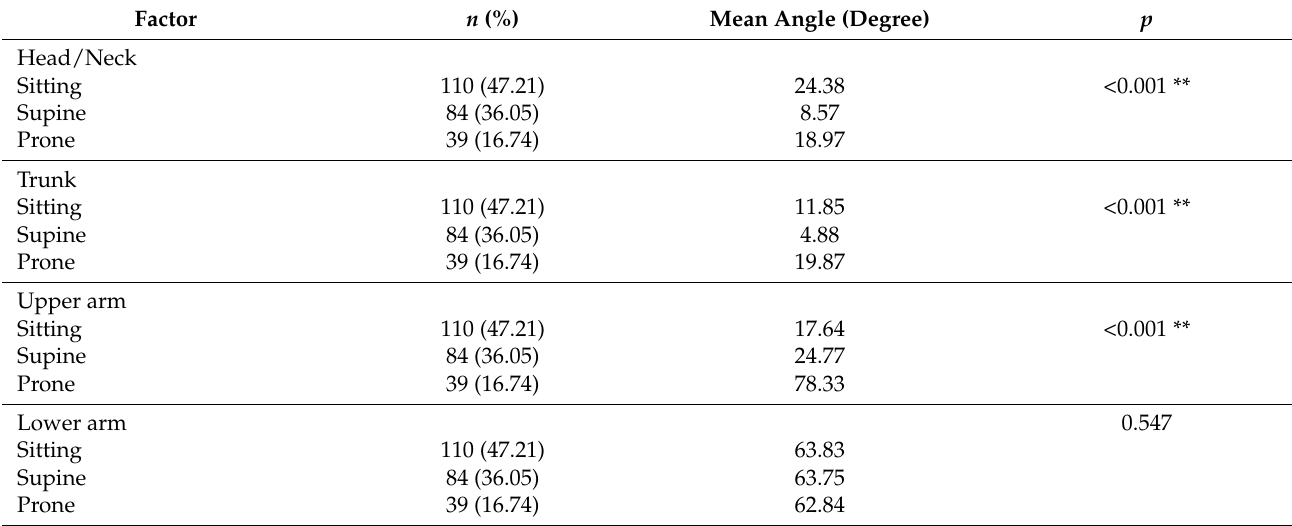
Table 2. Comparison between the different mean of body part angle in posture.